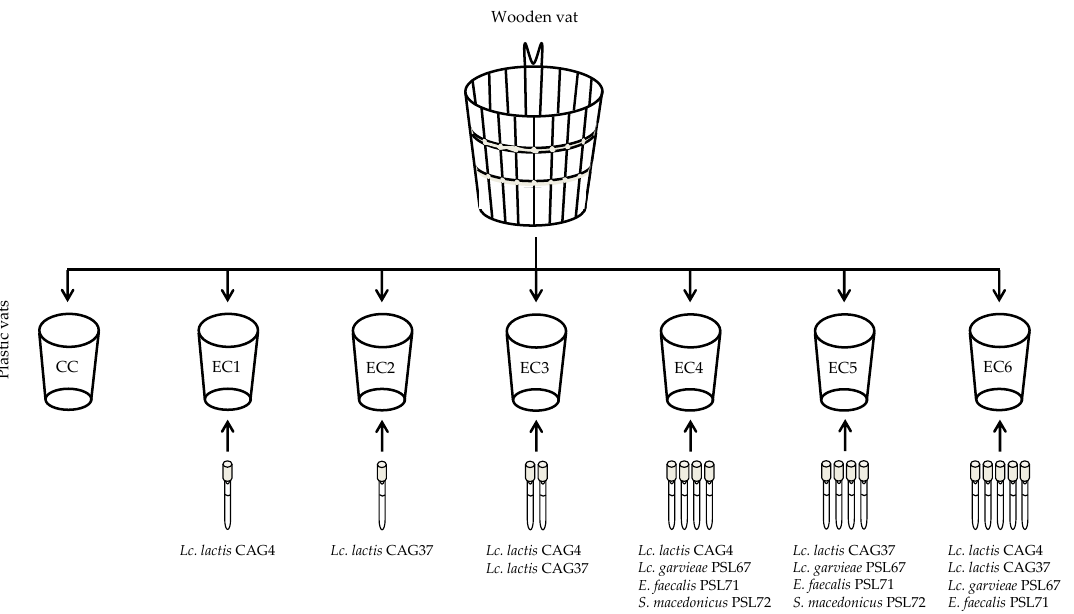
Figure 6. Experimental design of PDO Pecorino Siciliano cheese production performed at the factory-scale level. Adapted from Settanni et al. [16].